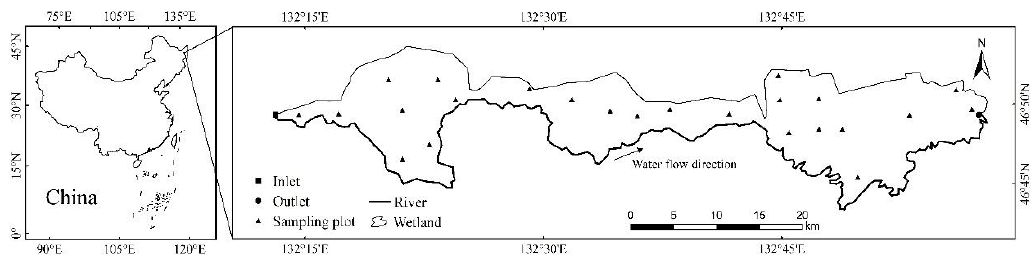
Figure 1. Sampling plots of TN, NH 4 -N, and NO 3 -N in the Sanhuanpao wetland in northeast China. Table 1. Location of sampling plots and TN, NH 4 -N, and NO 3 -N concentrations in the Sanhuanpao wetland.